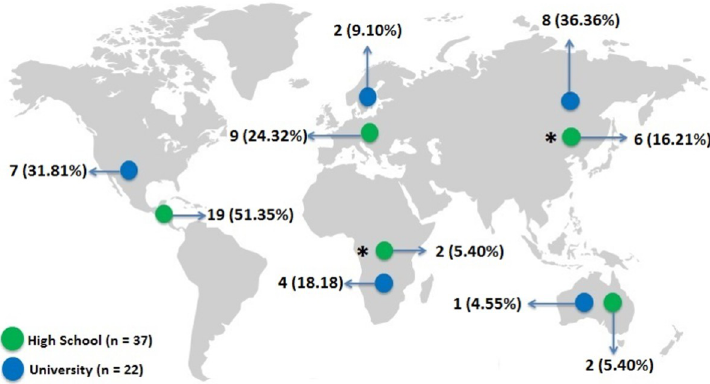
Fig 2. Total number of studies per geographic region ( � one study on high school students was carried out in two continents). Figure available at https://br.freepik.com/vetores-gratis/.